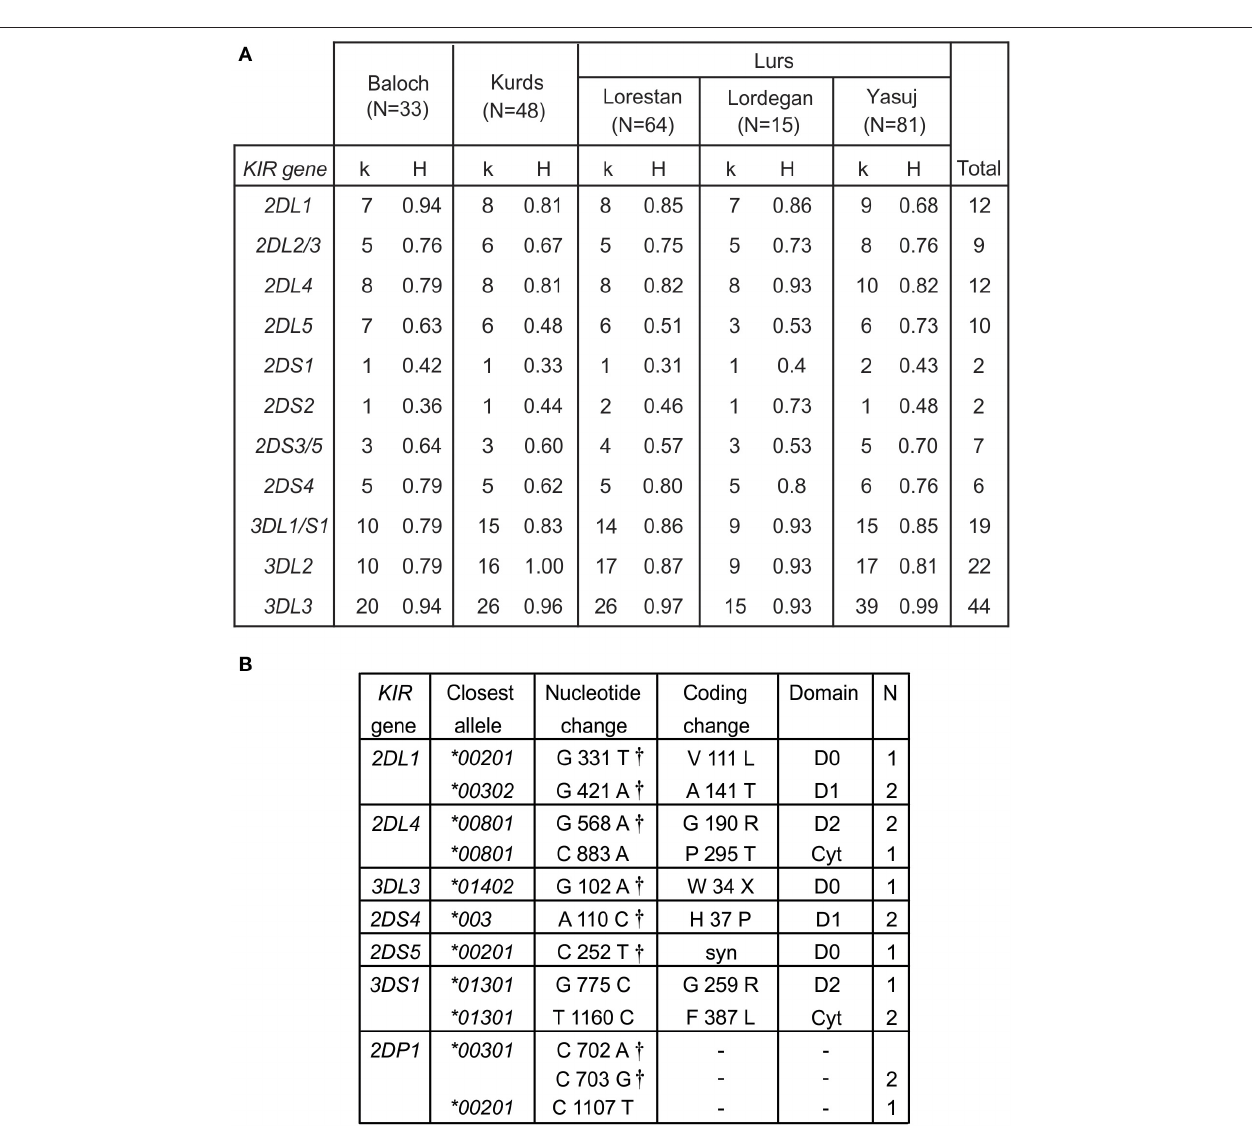
FIGURE 2 | High KIR diversity and allele discovery in Iranians. (A) Shows the numbers of KIR alleles (k) and the heterozygosity (H) in each of the five Iranian populations. The total number observed is shown at the right. Gene absence is not included as an allele. (B) Shows the novel KIR alleles identified in this study. Columns from left to right are: the KIR gene, the closest known allele, the nucleotide change compared to the closest allele, the amino acid substitution caused by the nucleotide change, domain affected by the amino acid substitution (LP, leader peptide; D0–D1, Ig-like domains; TM, transmembrane domain) and the number observed. † -indicates identical allele observed by Wagner et al.